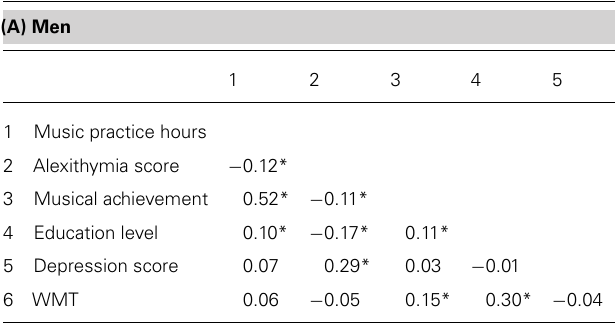
Table 1 | Product moment correlations between the study variables in participants who have ever played or sung (men and women).